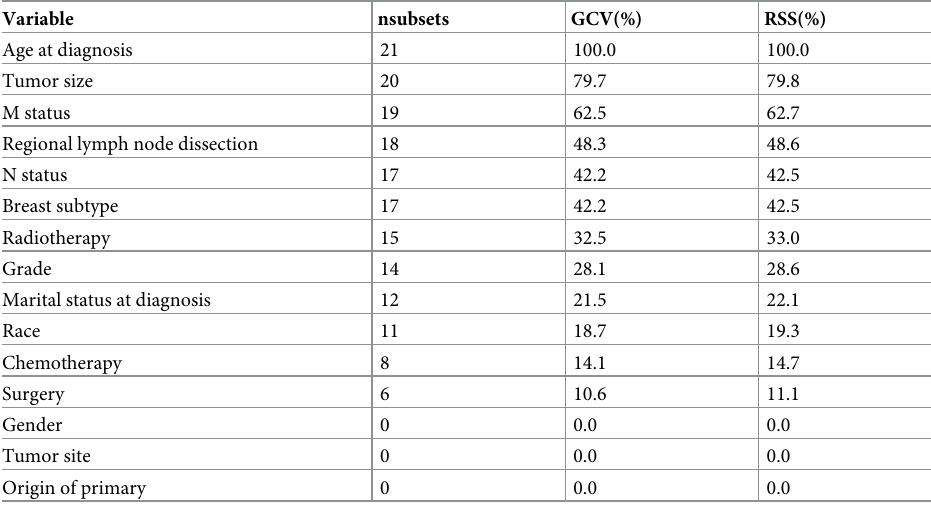
Table 4. The evaluation of variable importance in the MARS model.